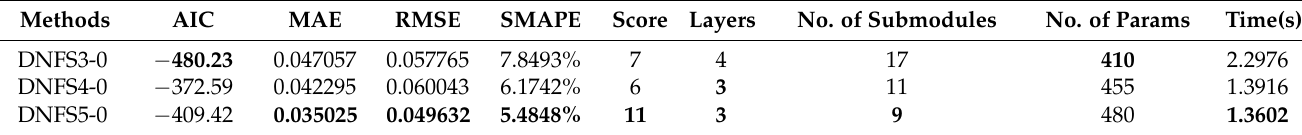
Table 3. The performance of DNFSs with different submodule inputs on Test Dataset No. 2.